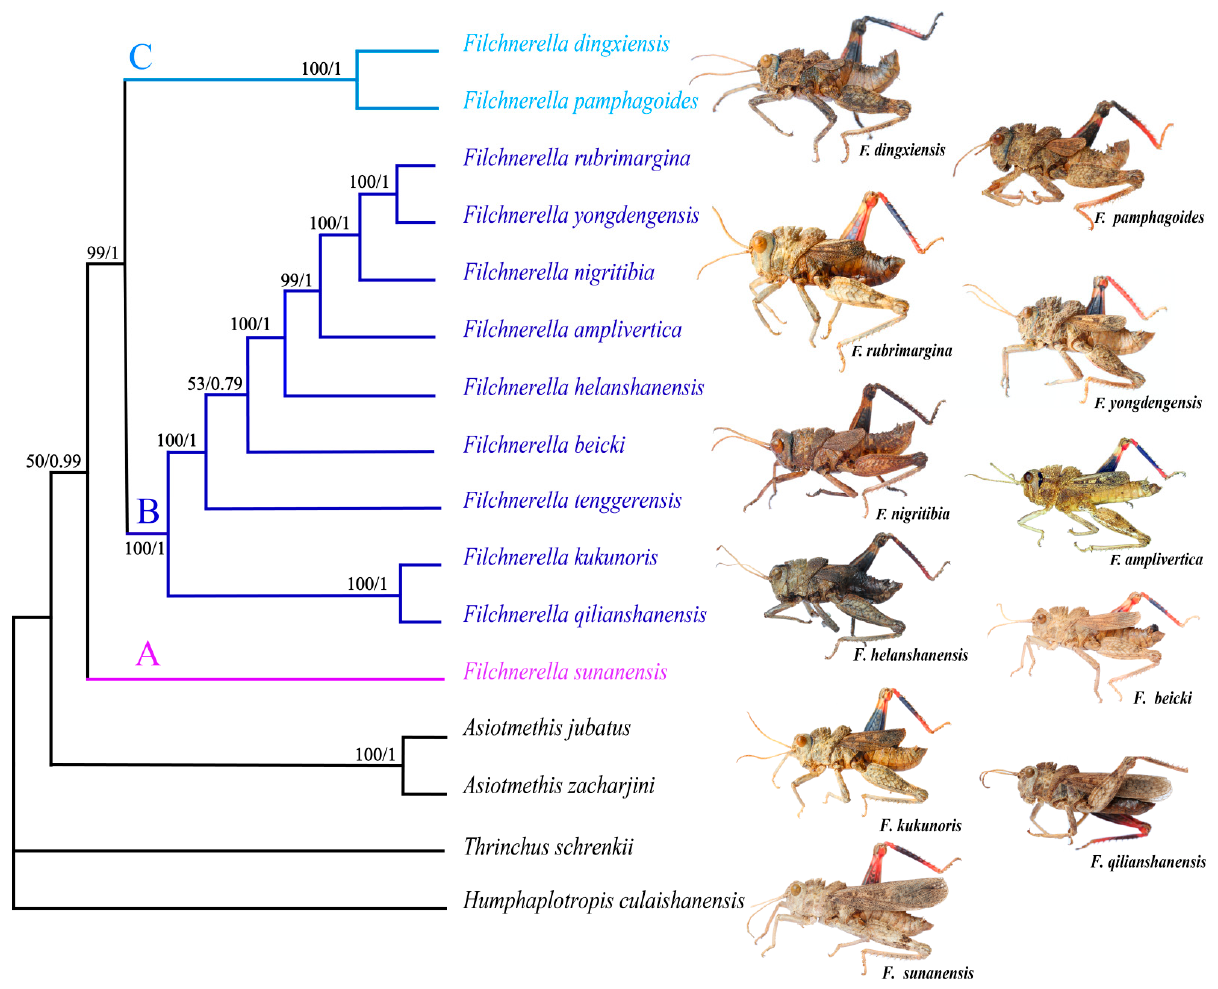
Figure 5. Phylogenetic relationships of 16 grasshoppers based on the concatenated nucleotide sequences of PCGs + rRNAs. Numbers on branches were Bootstrap values (BS, left ) and Bayesian posterior probabilities (PP, right ).